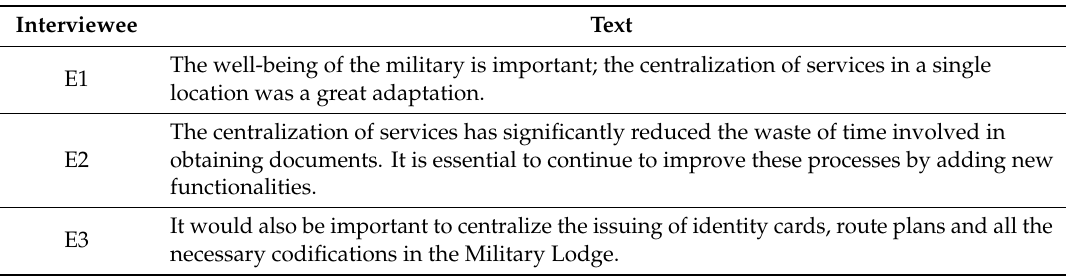
Table 1. Content analysis: the Military